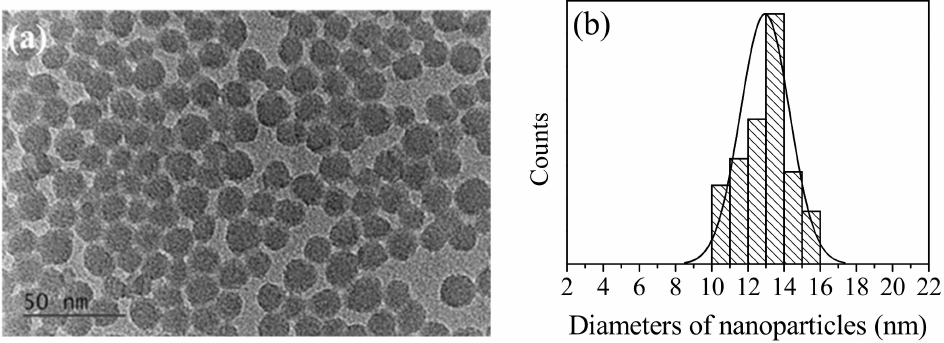
Figure 1. TEM pictures of SiO 2 particles in Ludox ® ( a ) and histogram distribution of their size ( b